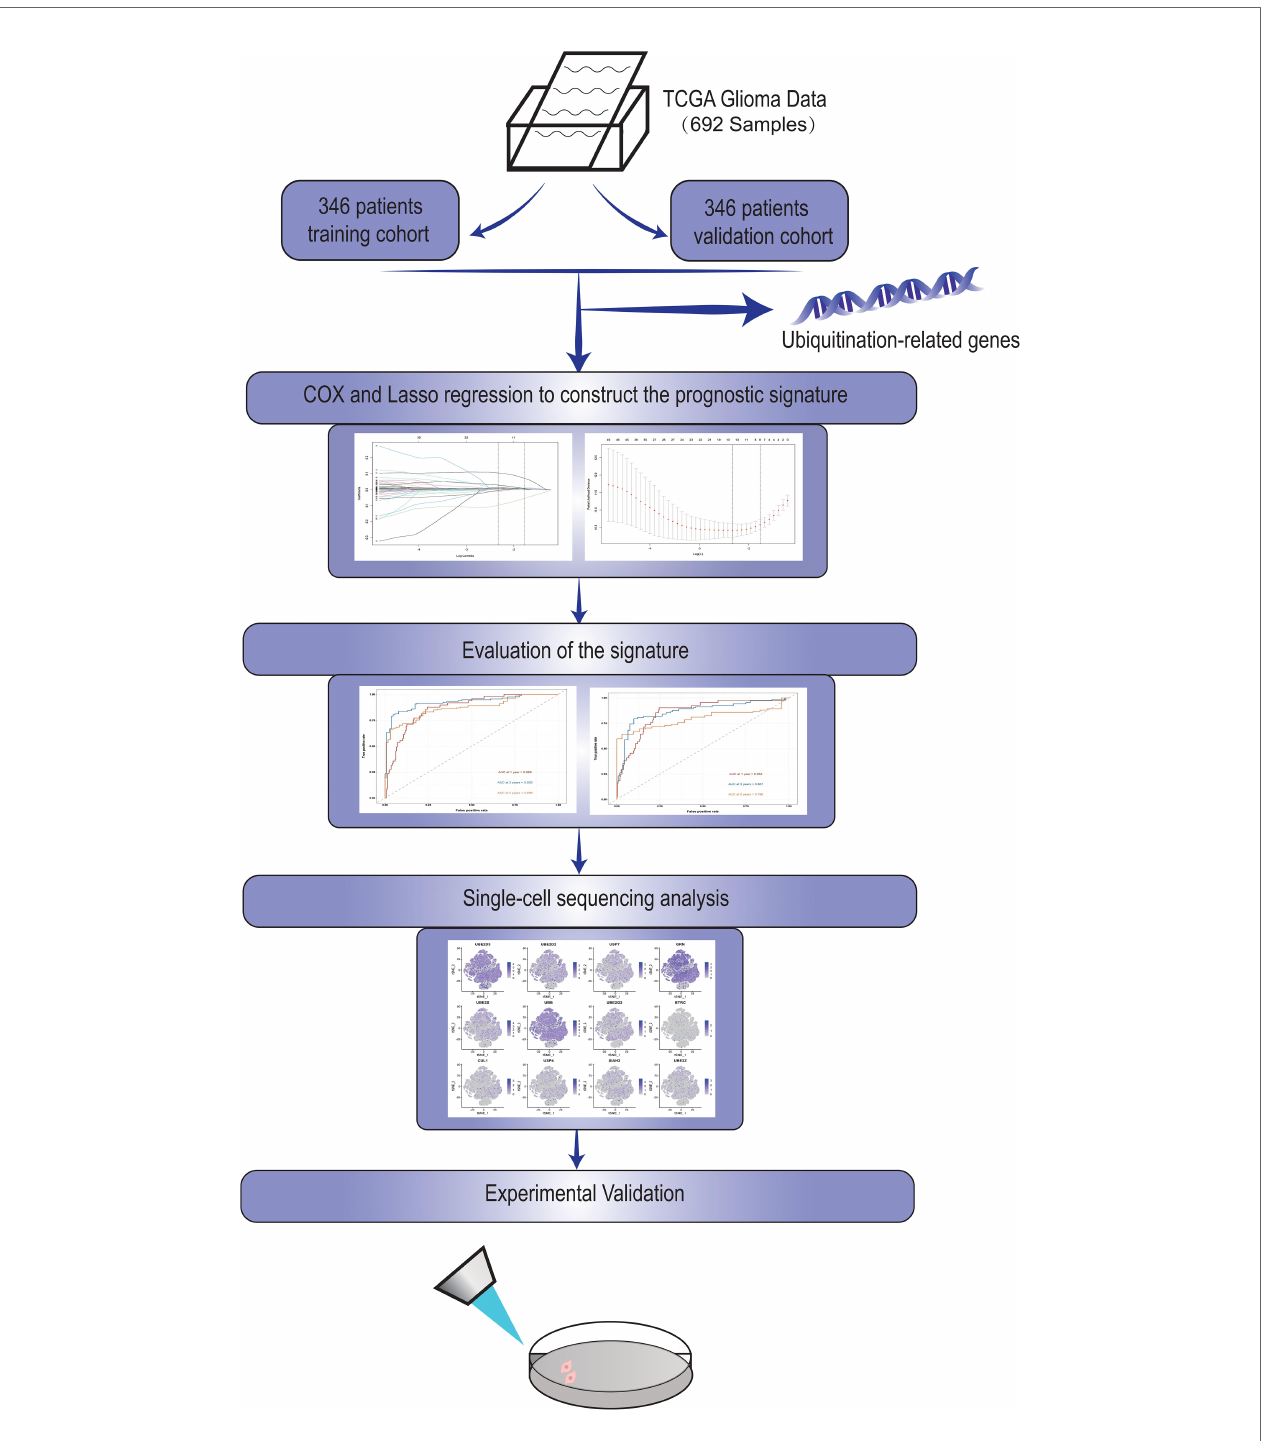
FIGURE 1 | The work fl ow of our